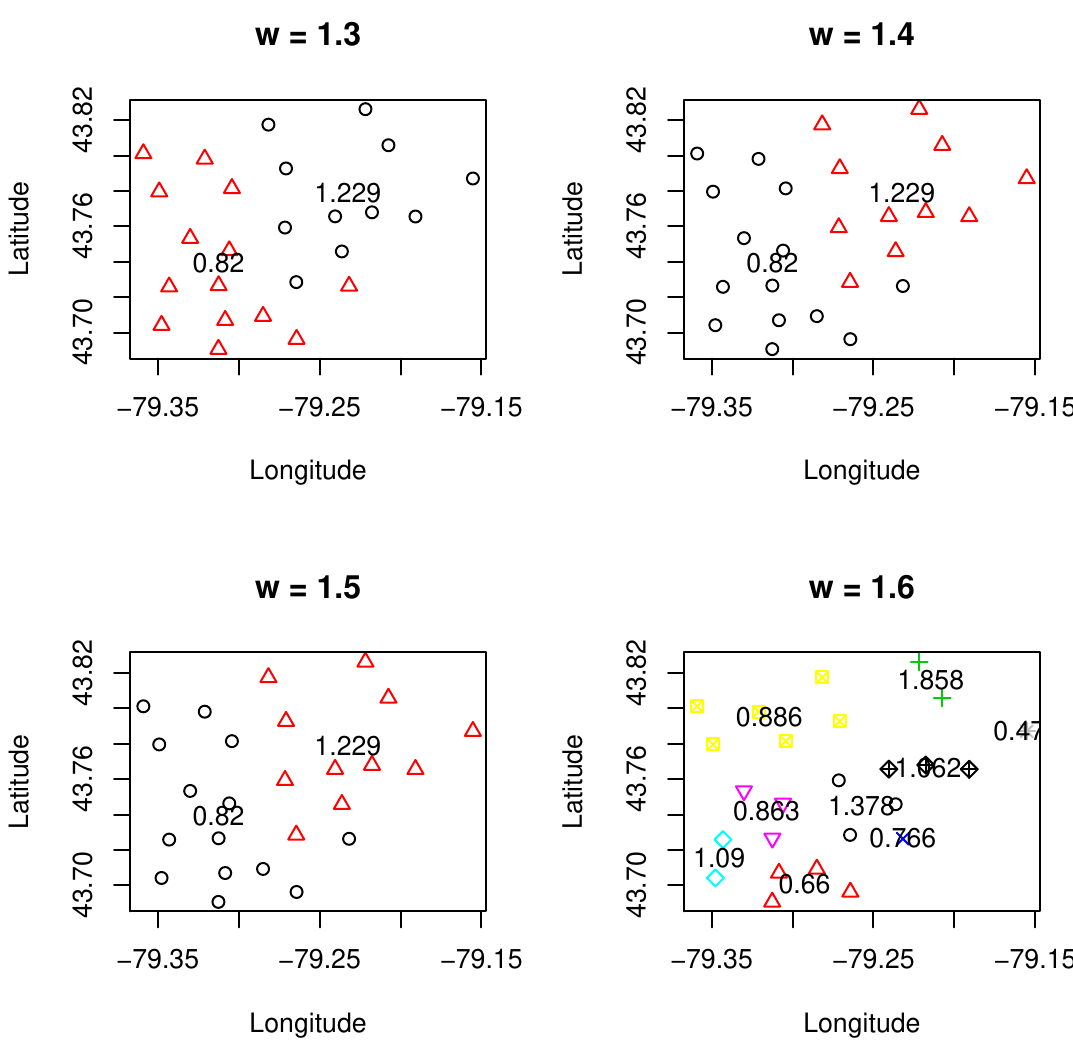
Figure 3. The weighted K -means clustering results using different values of w 1 (i.e., w 1 = 1.3, 1.4, 1.5 and 1.6, respectively) for a selected geographical area. The value indicated within each cluster represents the relativity of its loss cost to the overall average loss cost weighted by